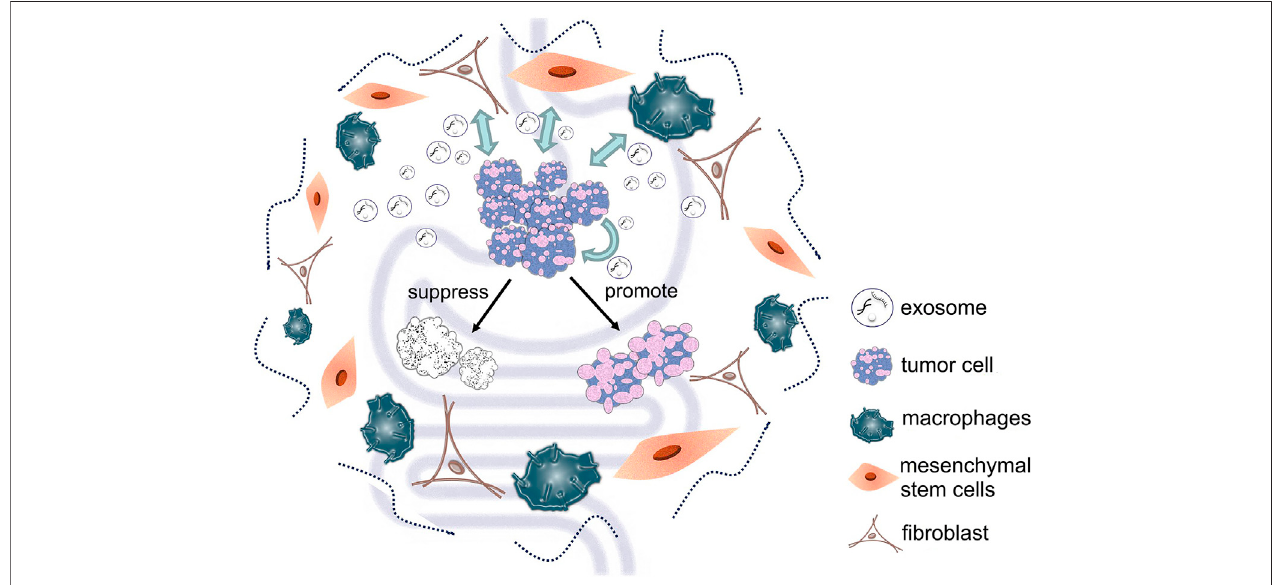
FIGURE 2 | Different types of cell-derived exosomes in the tumor microenvironment can deliver various substances to tumor cells, thereby affecting tumor cell development.